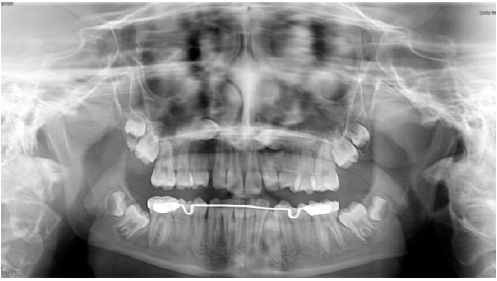
Figure 1. Pretreatment panoramic radiograph showing bilaterally impacted MM2 and upper canines.